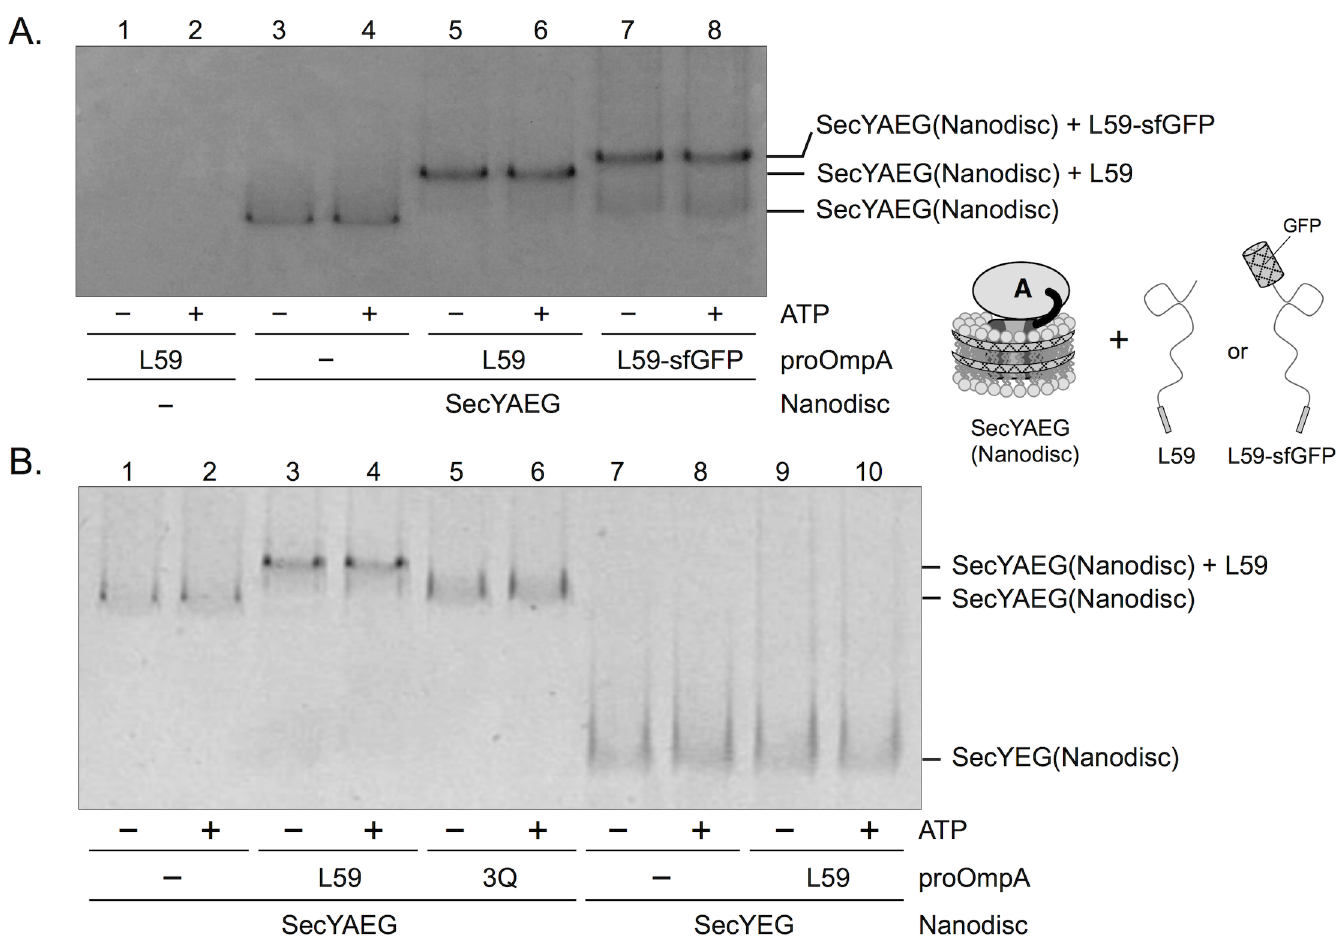
Fig 2. Stable complex of SecYAEG-reconstituted nanodisc and proOmpA. A, The mixture of SecYAEG-reconstituted nanodiscand proOmpA(L59) or proOmpA(L59)-sfGFP mutants, containing a disulfideloop nontranslocatablethoughthe SecYEG, was analyzedby native PAGE and Coomassie Brilliant Blue staining.These bands were interpretedas stable complexesof SecYAEG-reconstituted nanodiscswith or without proOmpA. The upshiftedbands were unaffectedby the presence or absenceof ATP. Schematic diagramsof the preparedproteins are shown. B, The upshifted bandswere not detected using a signal peptidemutant proOmpA, 3Q, or SecYEG-reconstituted nanodisc insteadof SecYAEG-reconstituted nanodisc.